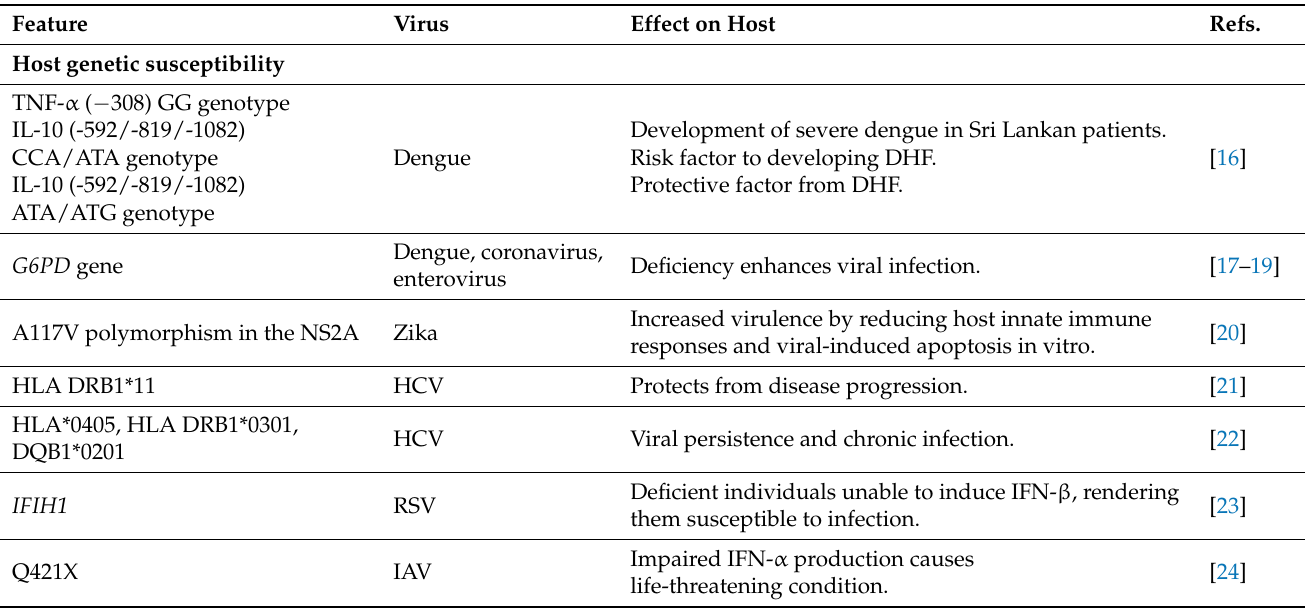
Table 1. Evidence of the influence of host features on viral infection. TNF = tumour necrosis factor; DHF = dengue hemorrhagic fever; HCV = hepatitis C virus; RSV = human respiratory syncytial virus; IAV = influenza A virus; WNV = West Nile virus; IFN = interferon; DC = dendritic cells; ACE2 = angiotensin-converting enzyme; Nab = neutralising antibody; HRV = human rhinovirus. Feature Virus Effect on Host Refs.